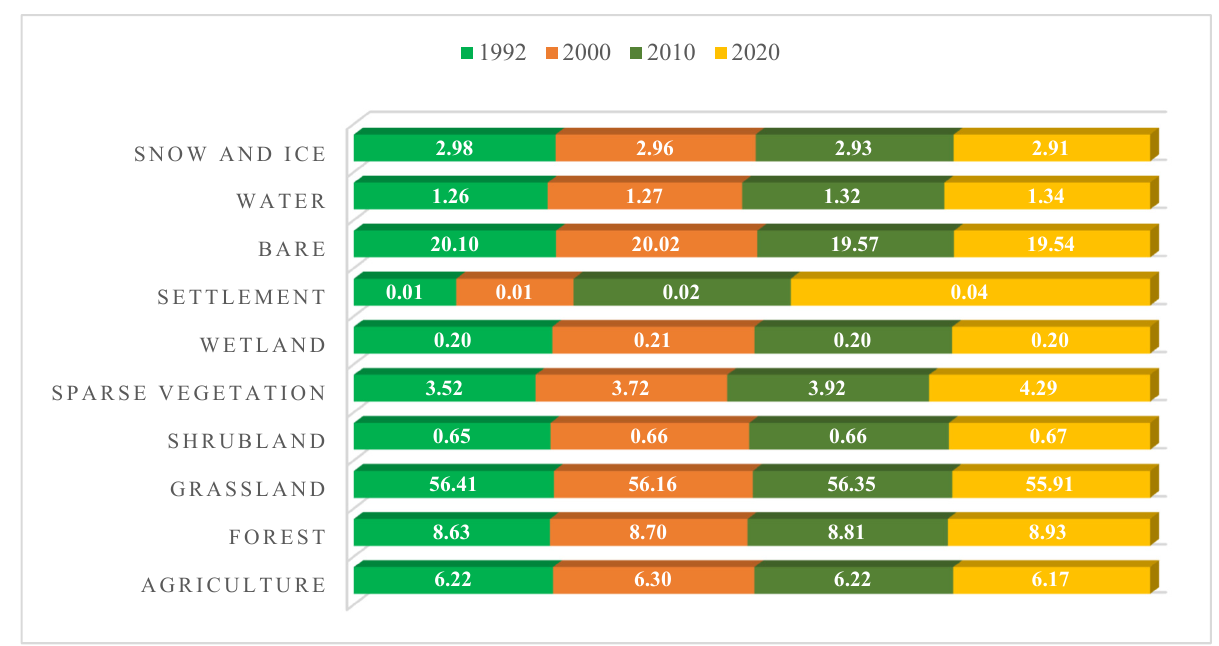
Figure 4. A graph shows the Third Pole’s decadal land-cover trends between 1992 and 2020 (Percent). Table 2. Decadal Land-cover changes at the Third Pole from 1992 to 2020.